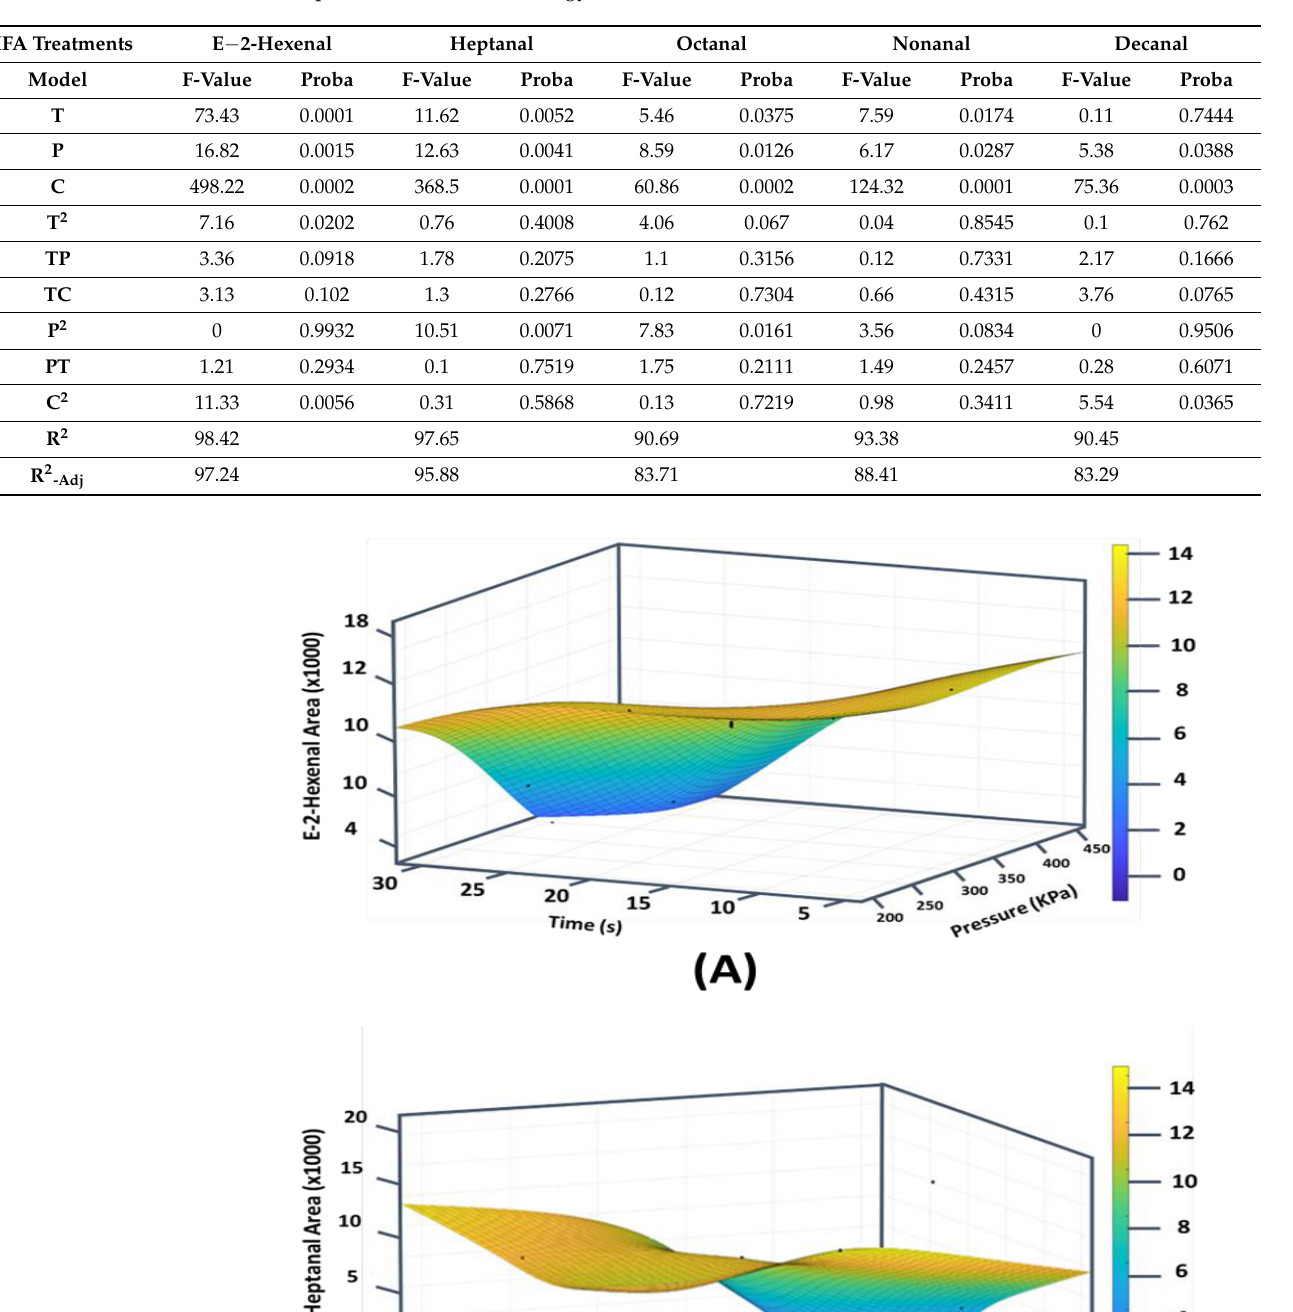
Table 4. Statistical data of DoE reduction rate (RR) versus MFA treatment parameters using RSM (response surface methodology).